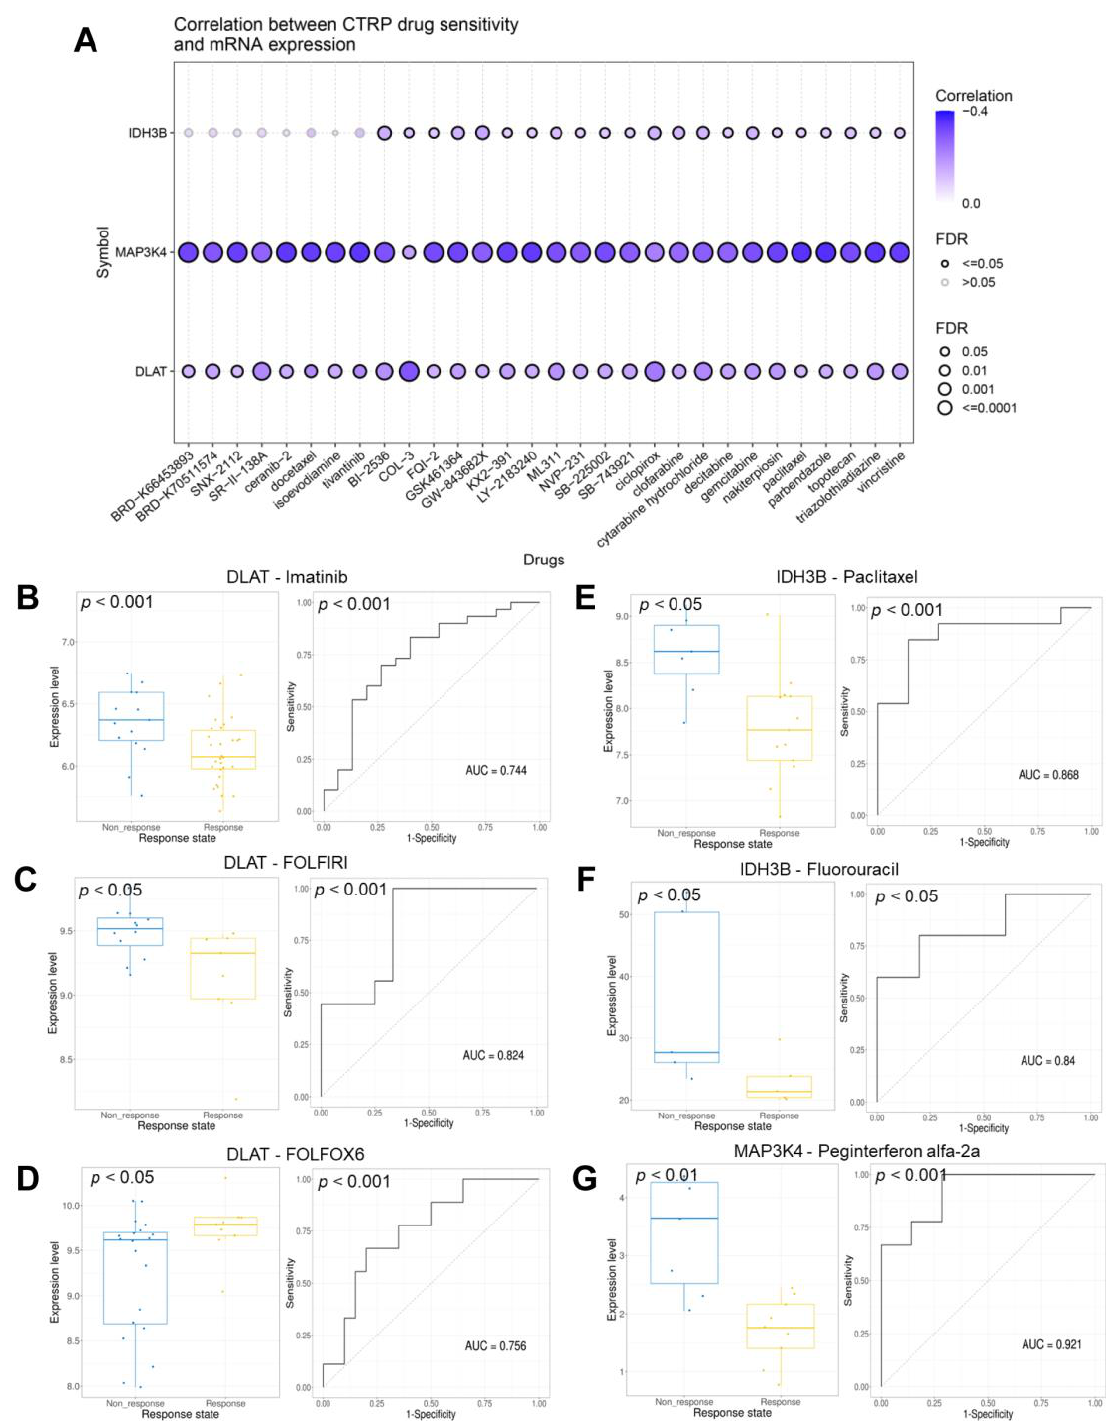
Figure 11. Analysis of the drug sensitivity and response. ( A ) The bubble plot showed the correlations between genes and drugs (top 30). The drugs were ranked by the integrated level of correlation coefficient and FDR of searched genes. ( B – D ) The ability of DLAT to predict response to imatinib, FOLFIRI, and FOLFOX6 therapeutic regimen. ( E – F ) The ability of IDH3B to predict response to paclitaxel and fluorouracil. ( G ) The ability of MAP3K4 to predict response to peginterferon alfa-2a. FOLFIRI, Fluorouracil + Irinotecan + Leucovorin; FOLFOX6, Fluorouracil + Leucovorin + Oxali- platin. Table 2. Data of drug response from CTR-DB.